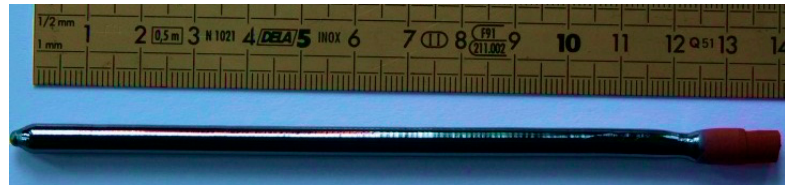
Figure 7. As-grown Ca 2 Fe 2 O 5 single crystal obtained by the floating zone method.